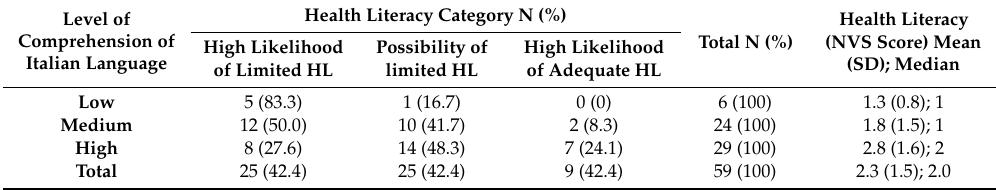
Table 4. The sample recruited during the job interview: health literacy by the level of comprehension of the Italian language (for foreigners, N = 59). For the health literacy category, χ 2 test: p = 0.07. For the NVS score, Kruskal–Wallis test: p =